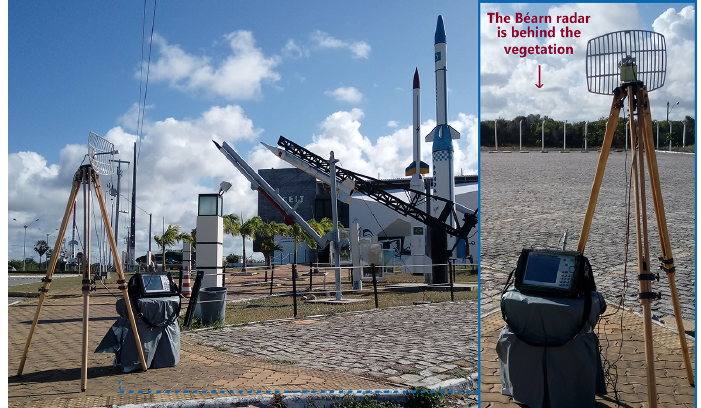
Figure 5. P03 measurement point: entrance of the space museum.